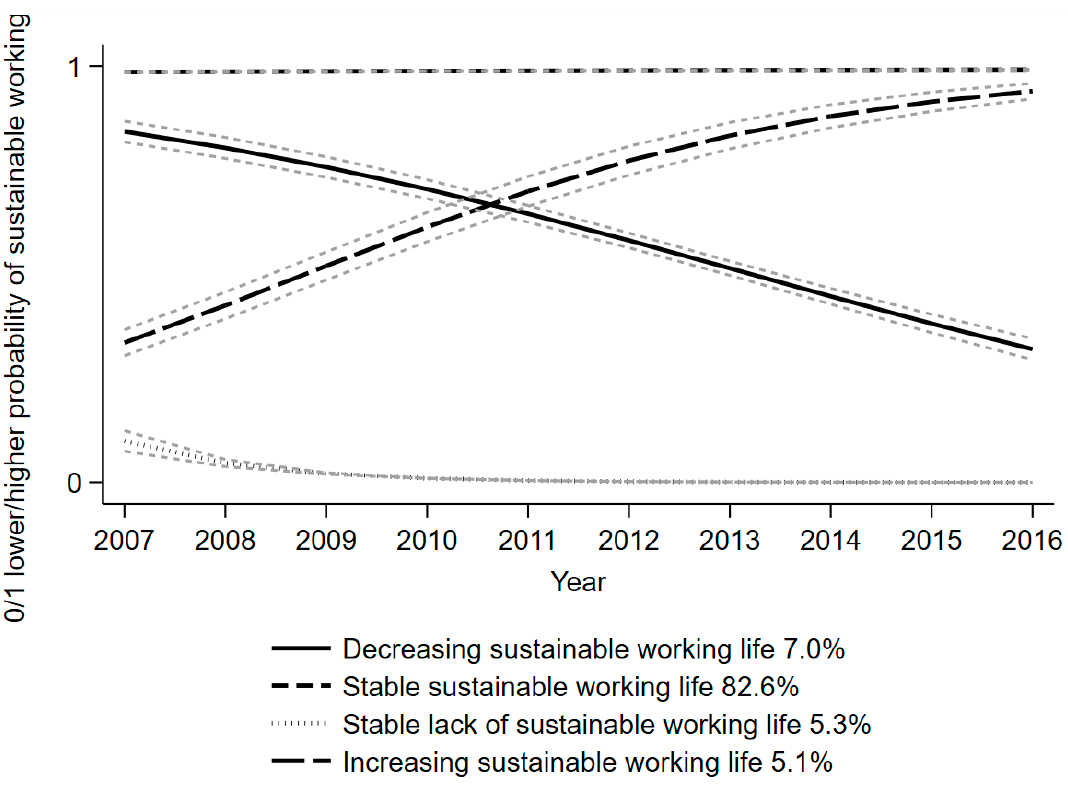
Figure 3. Trajectories of sustainable working life in the STAGE cohort from 2007 to 2016. In the figure, some of the 95% confidence intervals are very narrow and are almost invisible.